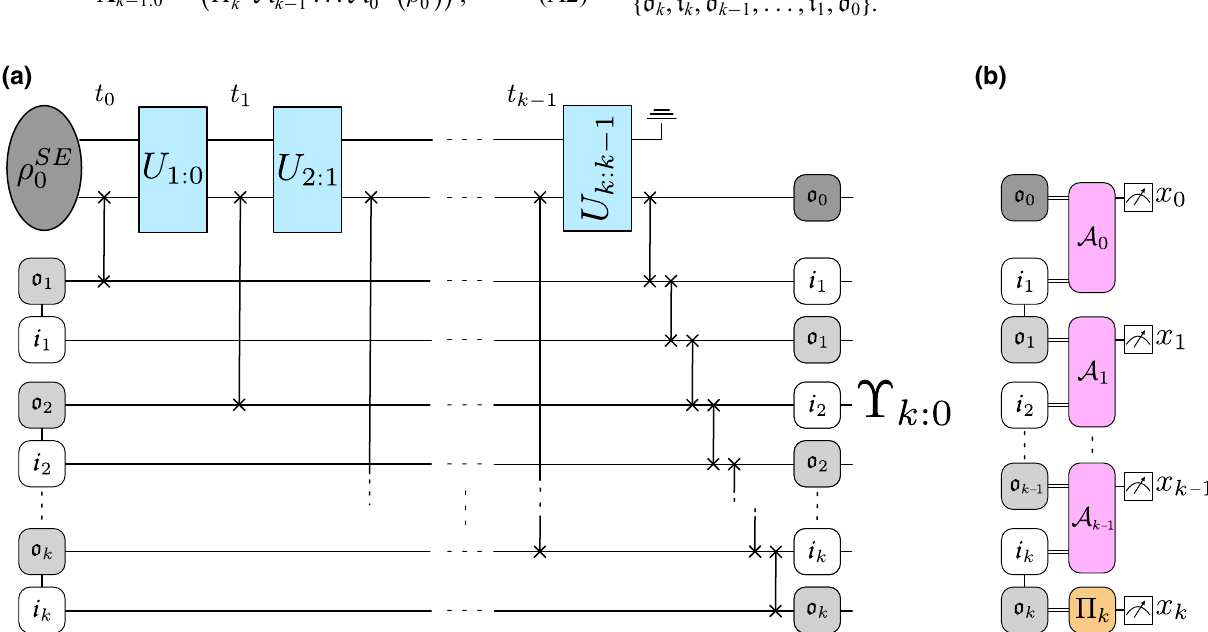
FIG. 12. Sampling the process-tensor Choi state. (a) The circuit construction of the Choi state of a k -step process using a general- ization of the Choi-Jamiolkowski isomorphism. One half of k Bell pairs is swapped into the process at each time. At the end of the circuit, a series of SWAP gates reorder the indices to correspond to causal ordering. (b) The resulting Choi state can be sampled with operations A j and measurement apparatus (cid:5) k , resulting in measurement outcomes x j